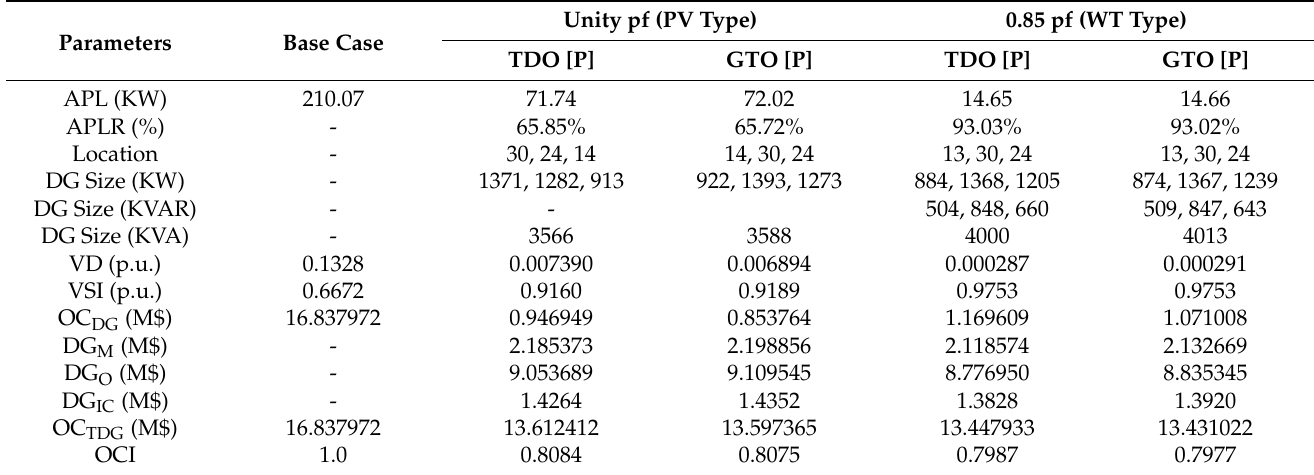
Table 8. Results of OADG for a 33-bus RDN for MOF in the CP load